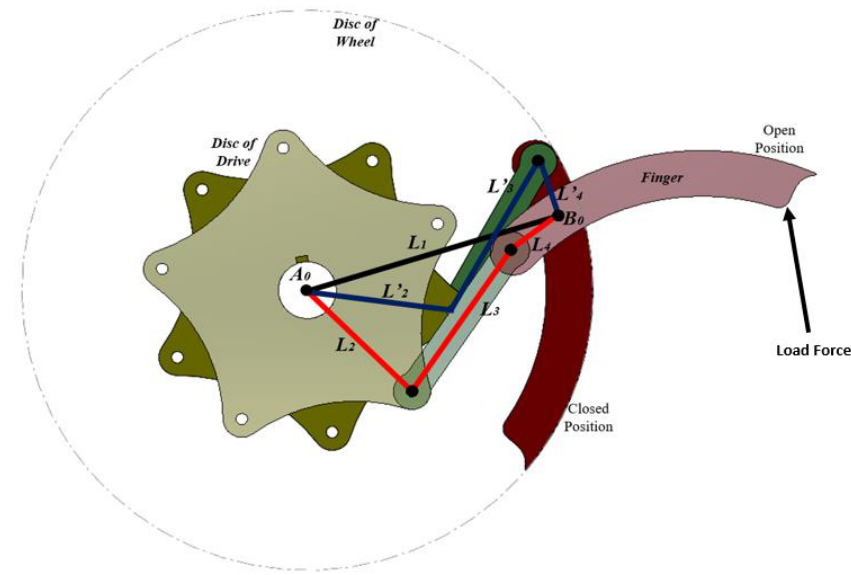
Figure 5. Four-bar mechanism for the movement of the fingers.